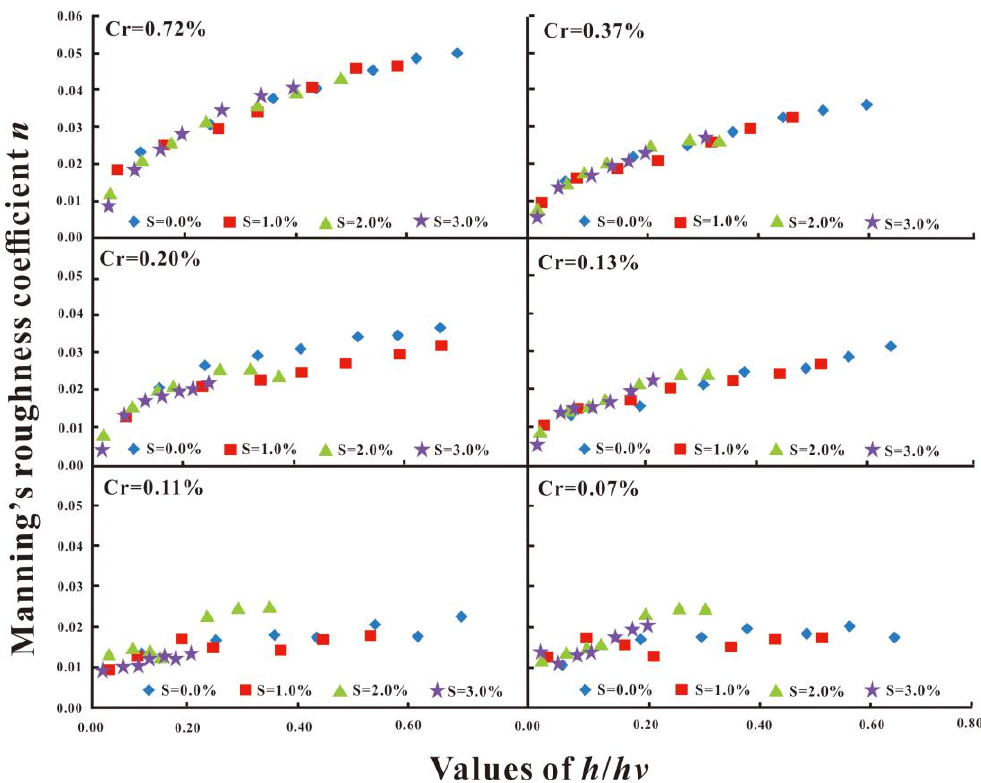
Figure 3. Manning’s roughness coefficient ( n ) for different combinations of ratio of water depth to vegetation height ( h / hv ), stem cover ( Cr ) and slope gradient ( S ). Stem cover range: 0.72, 0.37, 0.20, 0.13, 0.11, 0.07%; slope gradient range: 0, 1.0, 2.0,